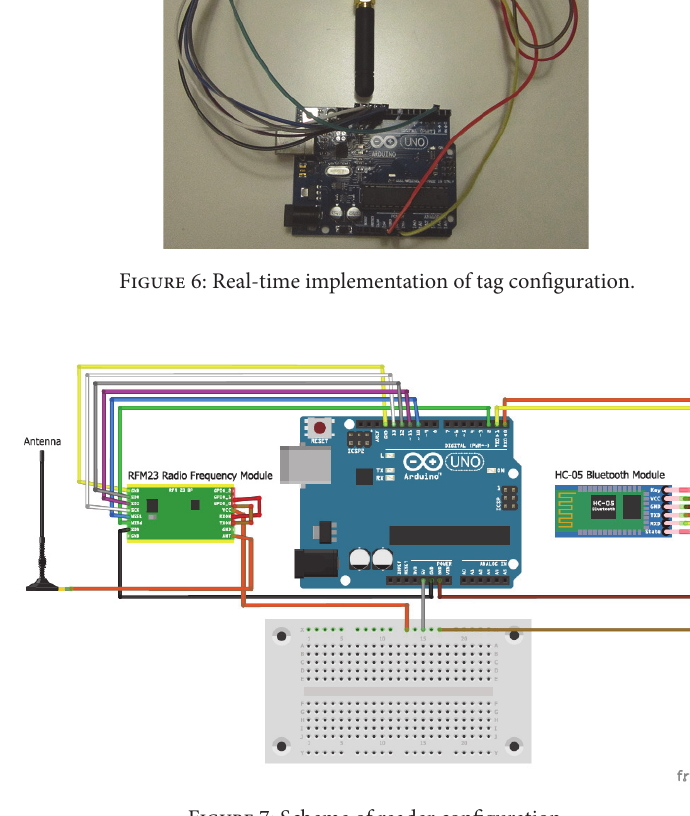
Figure 7: Scheme of reader configuration.